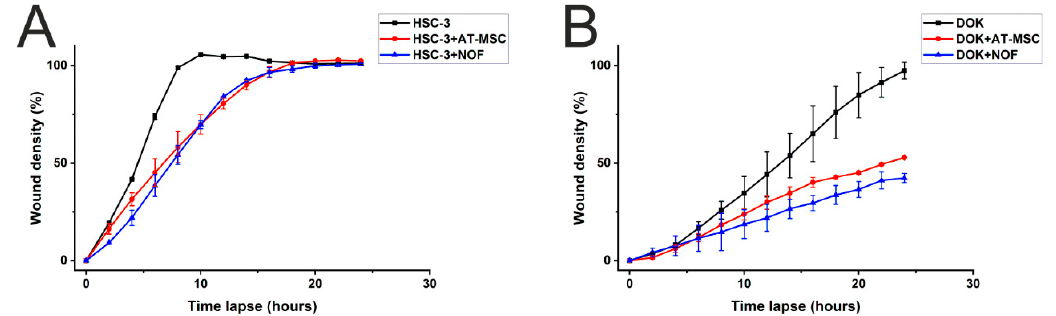
Figure 6. AT-MSC and NOF did not increase the migration of HSC-3 and DOK cells. IncuCyte wound migration assay was conducted to study the effect of AT-MSC and NOF on the migration of ( A ) HSC-3 cells and ( B ) DOK cells.